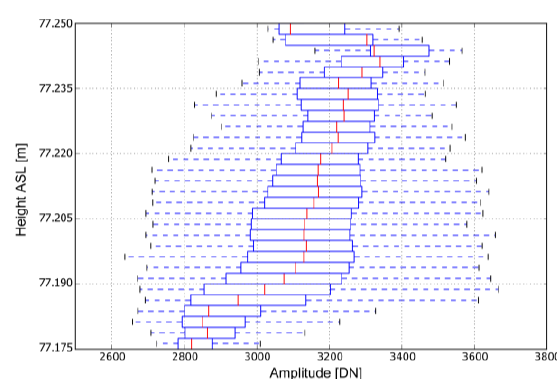
Figure 3. Density function of corrected amplitude of harvest residues (red) and bare soil (blue) of training data and the intersection point .